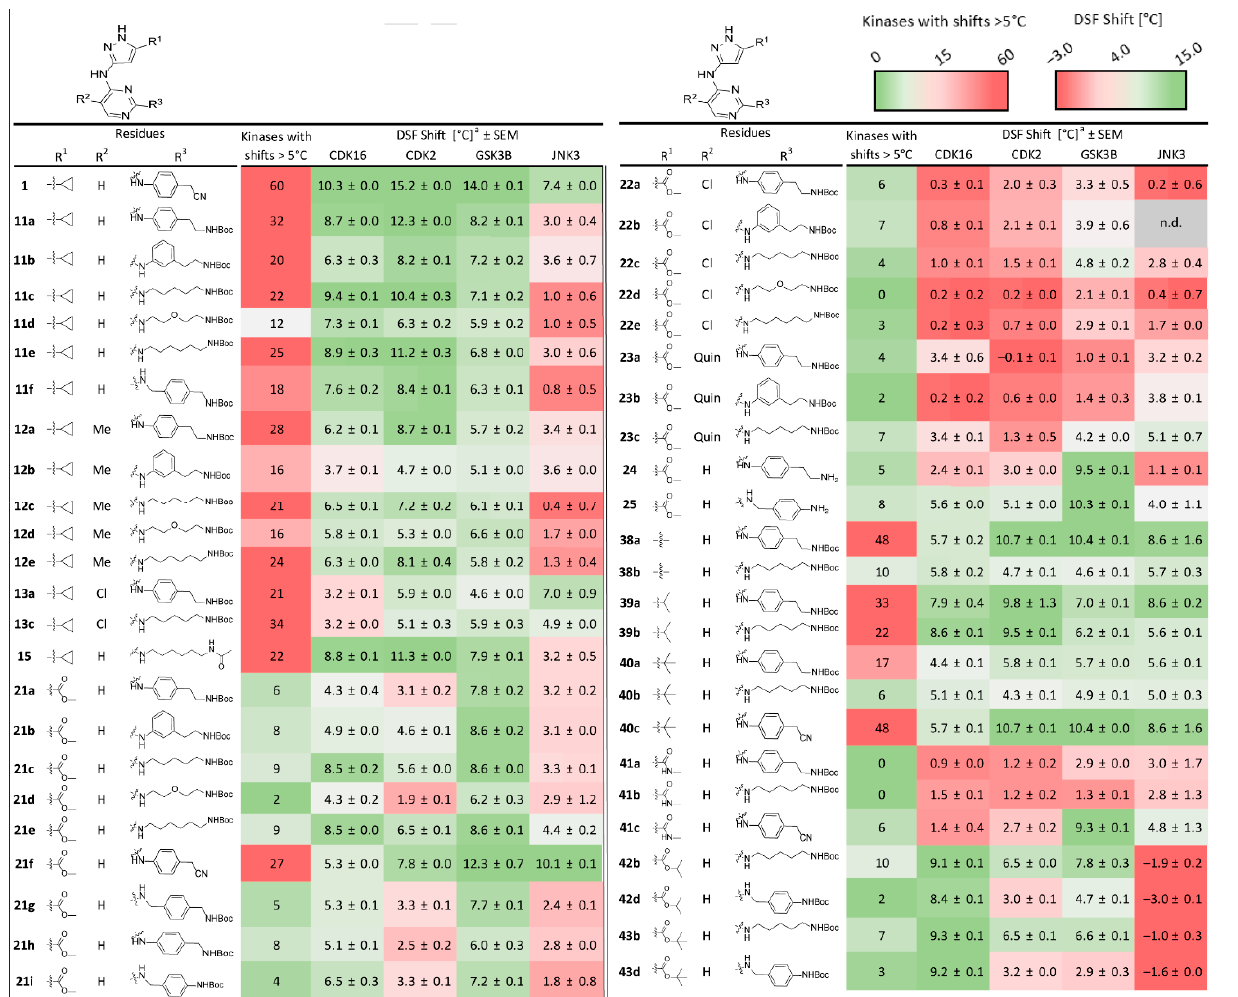
Figure 4. Heatmap of the DSF results of the N -(1 H -pyrazole-3-yl)pyrimidine-4-amine-based inhibitors against CDK16, CDK2, GSK3B, and JNK3 (red means a low stabilization of the desired kinase, green a high stabilization). The number of kinases with shifts >5 °C provided an indication of the selectivity profile of the newly synthesized compounds (red indicates a high number of stabilized kinases and therefore a promiscuous behaviour, green a low number of stabilized kinases). a DSF measurements were performed in duplicates (± SEM).